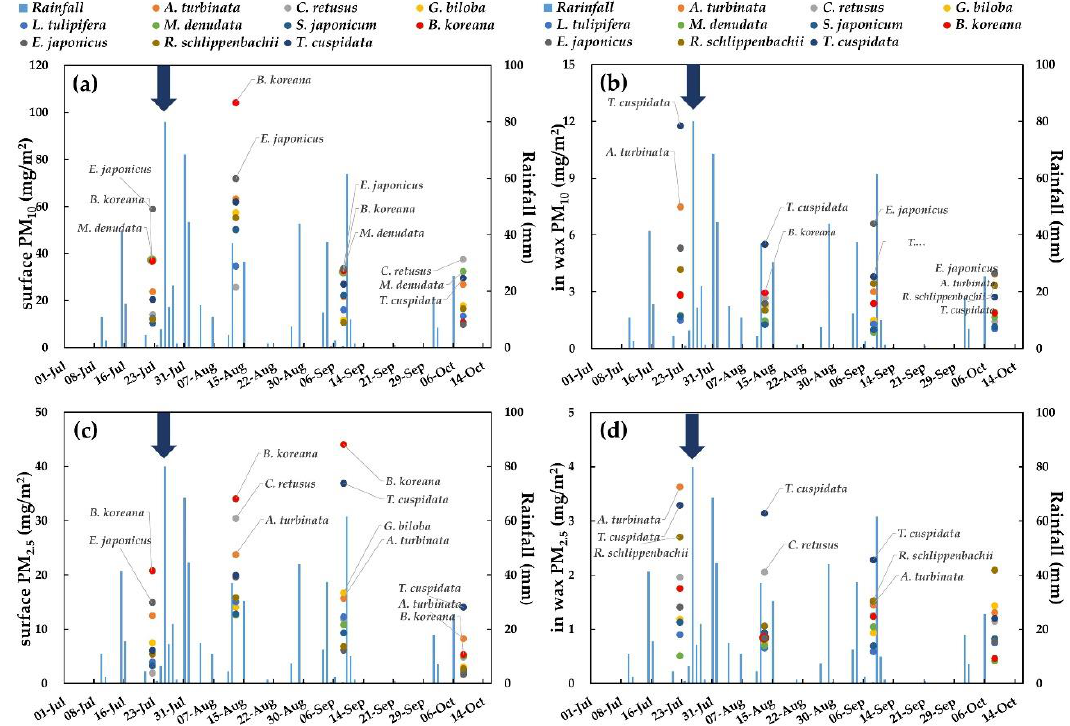
Figure 4. Monthly variations of PM particle amounts (mg/m 2 ) accumulated both on leaf surfaces and in epicuticular wax layers of ten tree species at the Seoul Forest Park during seasonal rainfall events in Seoul, Korea: ( a ) Surface PM 10 ; ( b ) in wax PM 10 ; ( c ) surface PM 2.5 ; and ( d ) in wax PM 2.5 . Note: Arrows indicate the onset of the summer rainy season.